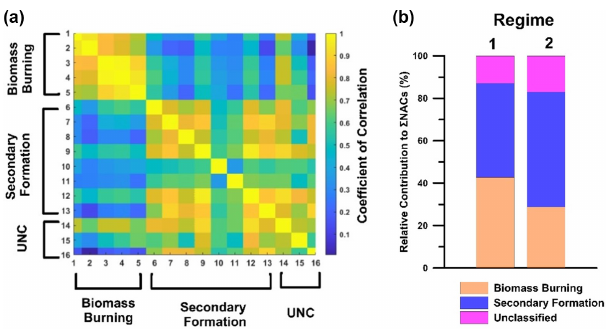
Figure 10. (a) Correlation matrix for gas-phase NACs under regime 1. (b) Relative contributions of the identified NAC classes under regimes 1 and